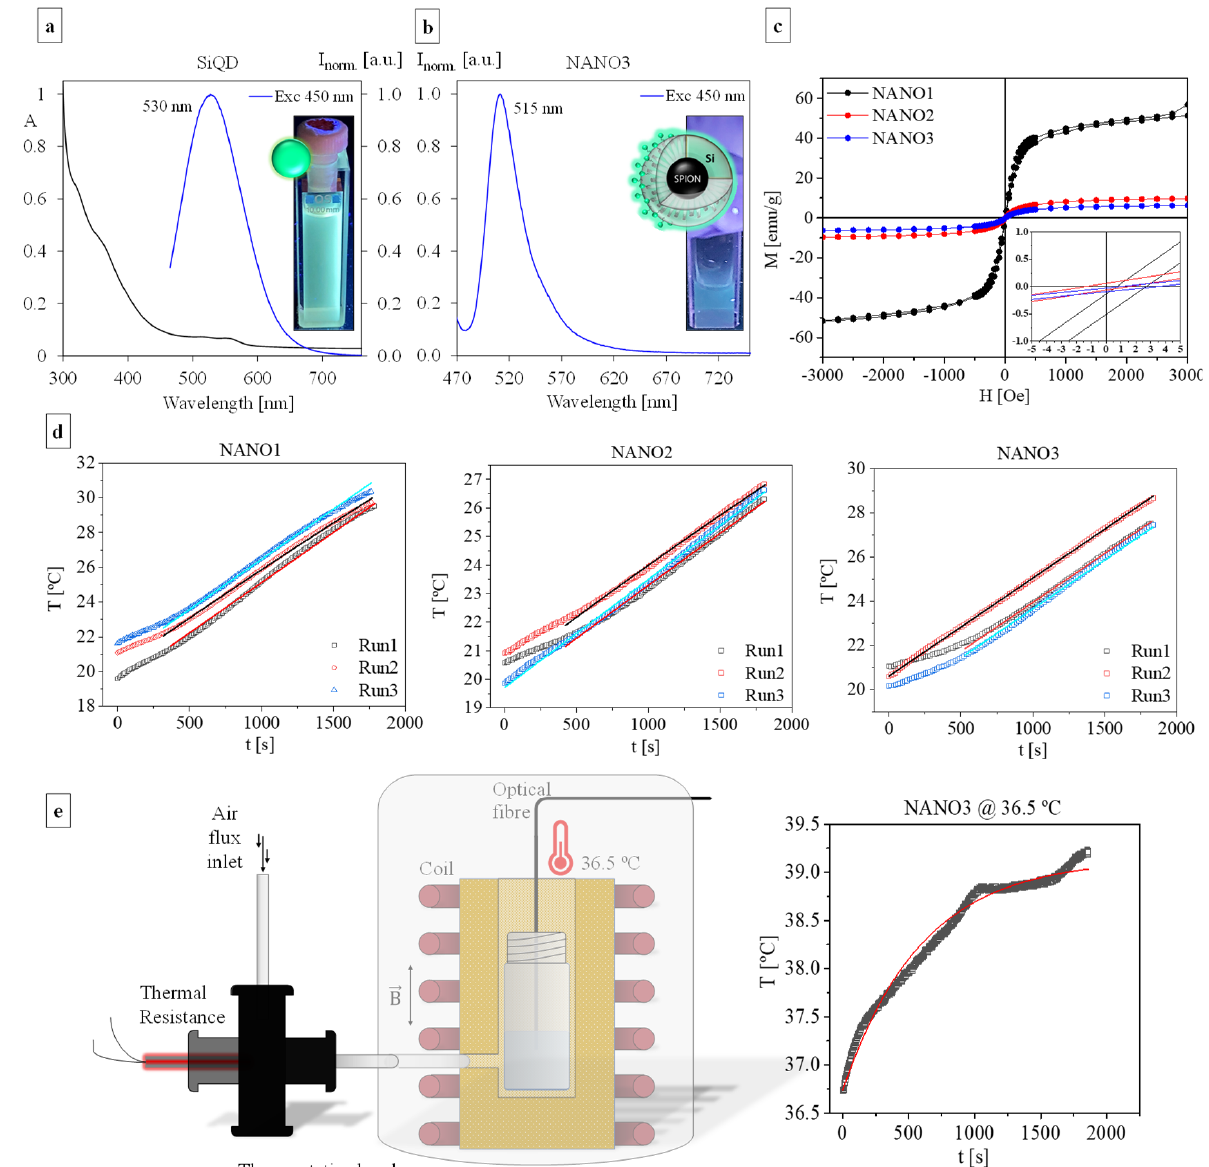
Figure 3. Absorbance and fluorescence spectra of SiQD, after excitation at 450 nm; inset: in-solution picture of SiQD dispersion under 365 nm irradiation ( a ). Fluorescence spectra of as-synthesized NANO3; inset: in-solution NANO3 under 365 nm irradiation ( b ). VSM magnetization loops of